Question: Sum up the contents of this chart in one sentence.
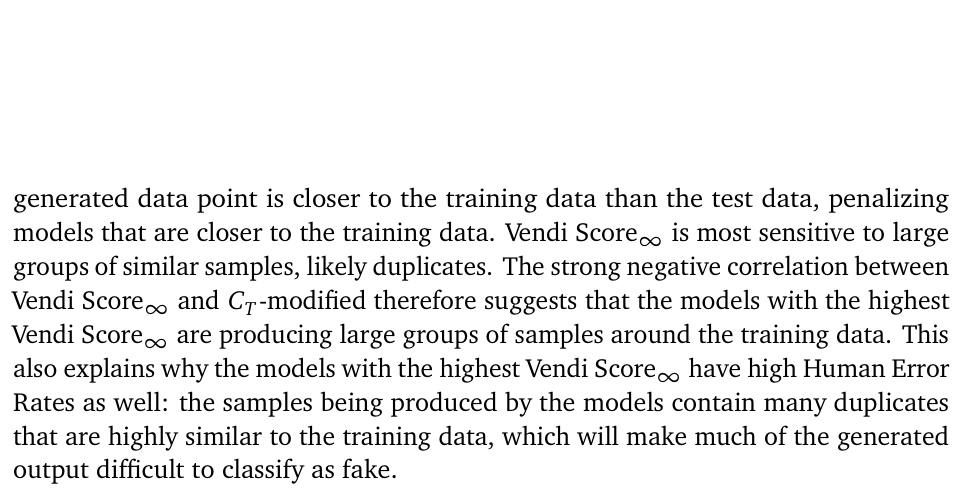
Answer: provides a comprehensive overview of all tested metrics and their cor- relations. Notable in the figure is the strong negative correlation between Vendi Score∞and the metrics used to measure sample quality, namely Fréchet Distance (FD) (Heusel et al., 2017; Stein et al., 2023), and Kernel Distance (KD) (Bi´nkowski et al., 2018; Stein et al., 2023). Models with low FD and KD have high sample quality by definition. Due to the strong negative correlation between Vendi Score∞ and FD and KD, models with good sample quality as measured by FD and KD tend to produce duplicates, since they have high Vendi Score∞. This is the same conclusion we drew earlier, looking at human error rate and Vendi Score∞. We also take note of the correlation between the Vendi scores and coverage, another metric used to measure diversity (Naeem et al., 2020). Coverage measures how many training data points are ’close’ to any generated data point. Models with a high Vendi Score∞ are producing images centere